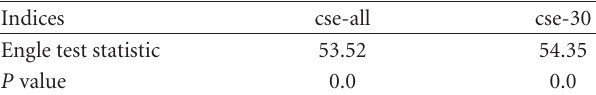
Table 4: Linearity test results. Table 5: GA